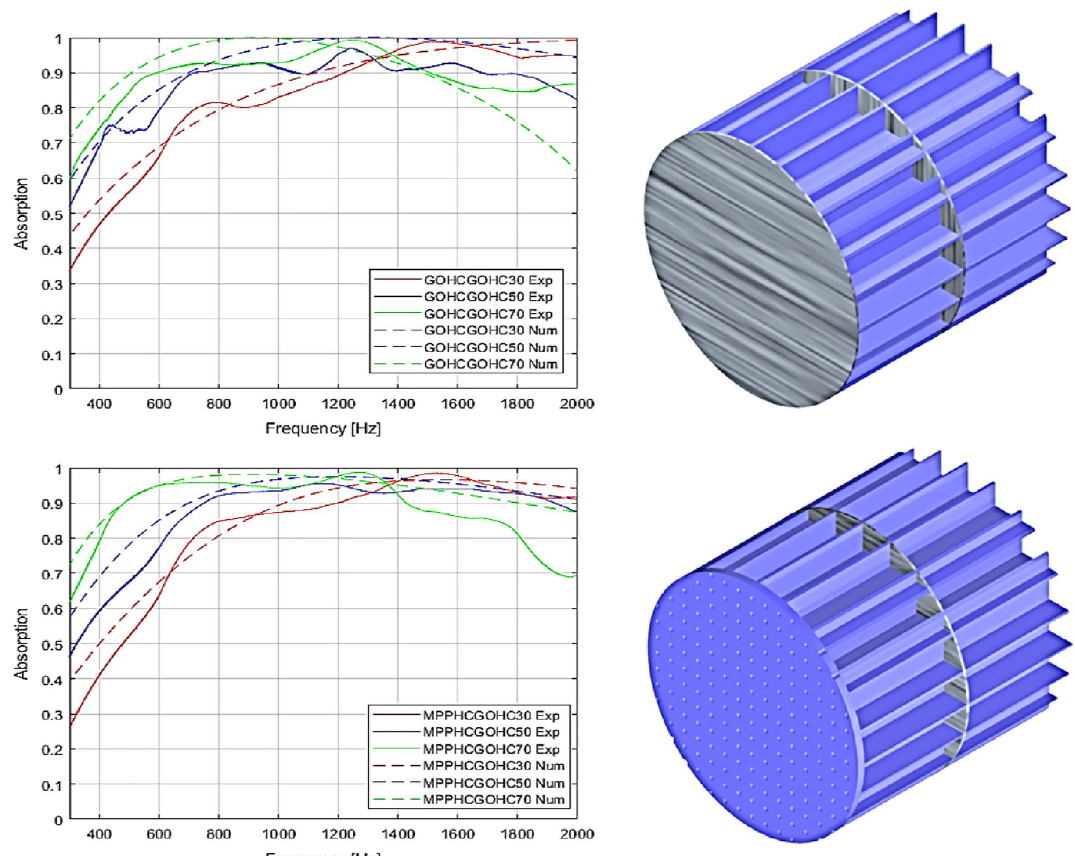
Figure 2. Absorption coefficient for the proposed MPPHCGOHC and GOHCGOHC structures with different thickness compared with the analytical